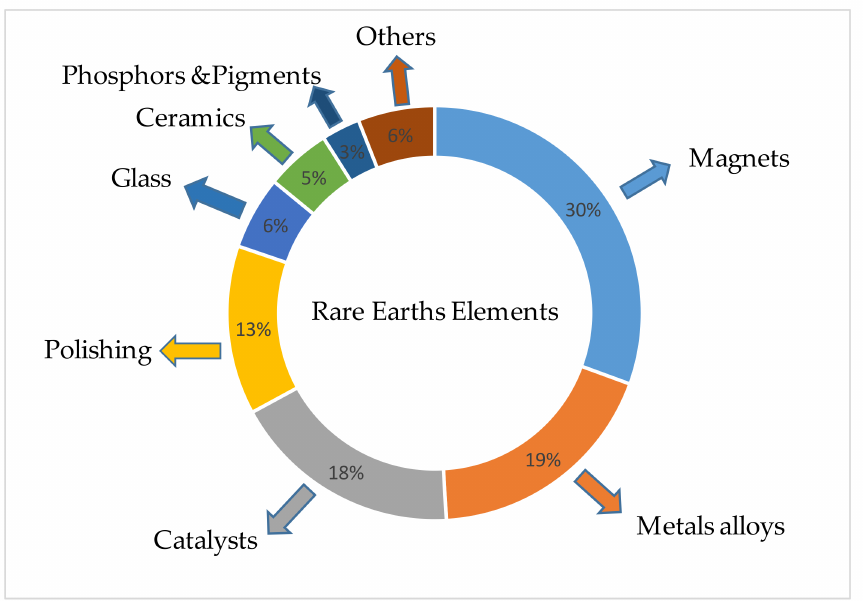
Figure 1. Estimation of global REE demand by applications in 2017 (adapted and modified from